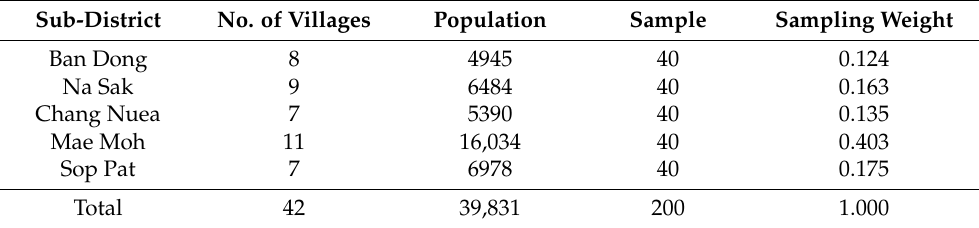
Table 3. Population and sample size across the five sub-districts of the Mae Moh District. Source: Authors, ref.